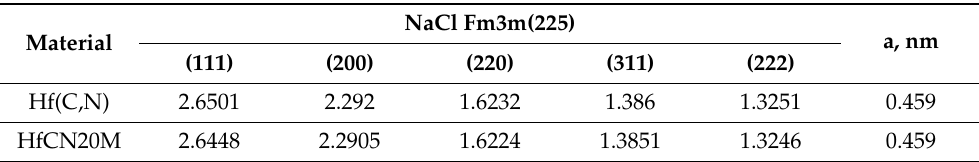
Table 1. D-spacing for the bulk Hf(C,N) and Hf(C,N)-MoSi 2 .